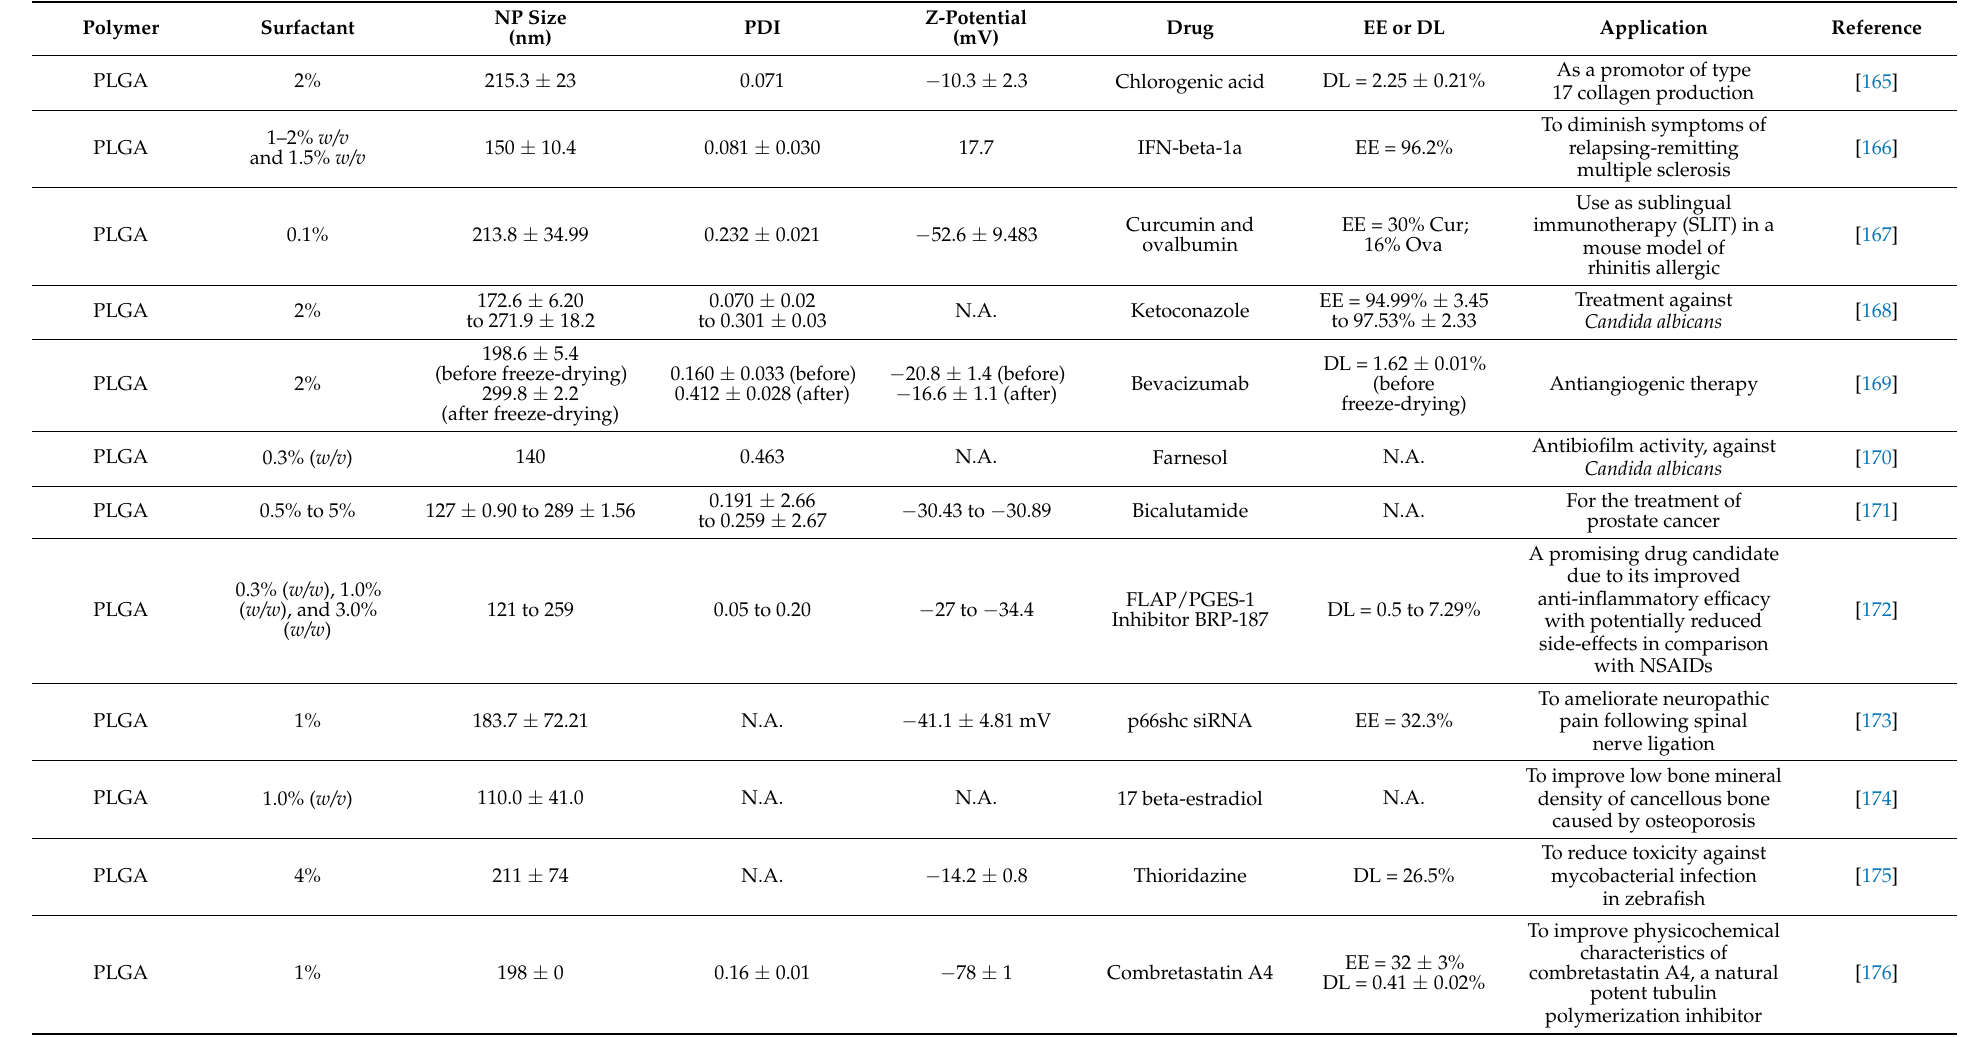
Table 3. Nanoparticulate formulations stabilized with